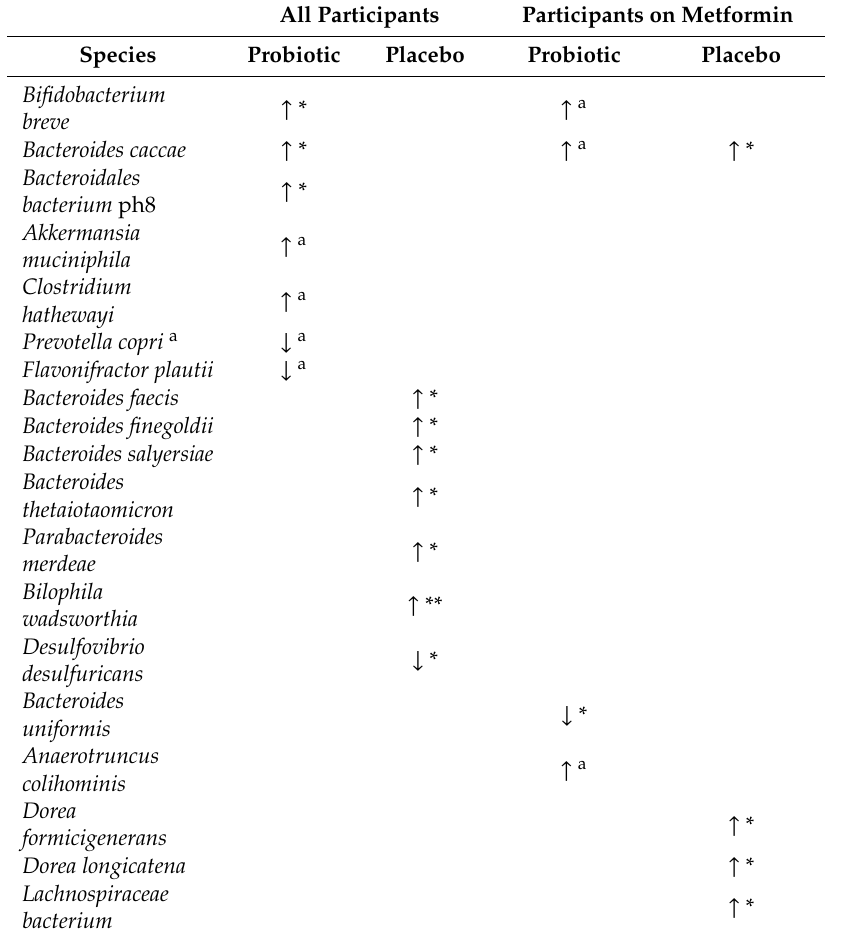
Figure 2. Shift in intestinal microbial profile after the 12-week intervention. ( A ) Microbial profile at the phylum level in each groups and timeline. ( B ) Principal coordinate analysis (PCoA) of Bray–Curtis distances at the species level between the intestinal microbial communities of subjects in each group. Table 3. Changes in relative abundance at the species level by intervention group and within participants taking metformin.